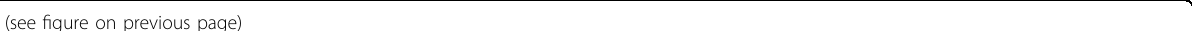
Fig. 6 Metabolic disease-related hIRS-1 G972R mutant displays altered phase transition dynamics. a DIC images of LLPS of FLAG-hIRS-1 and FLAG-hIRS-1 G972 mutants at a series of protein concentrations (5 or 10 μ M). The proteins were incubated with phase separation buffer at room temperature for 10 min. Scale bar, 20 µm . b Immunoblot analysis of the IRS-1 expression levels in C2C12 wildtype, C2C12-IRS-1 KO/GFP-hIRS-1, and C2C12-IRS-1 KO/GFP-hIRS-1 G972R cell lines. c Confocal images of GFP-tagged hIRS-1 or G972R mutant in C2C12-IRS-1 KO/GFP-hIRS-1 or C2C12-IRS-1 KO/GFP-hIRS-1 G972R cell lines. Scale bar, 10 µm. Quanti fi cation results of GFP-hIRS-1 or G972R puncta are shown as violin plots. * p < 0.05. d FLAG- tagged hIRS-1 or hIRS-1 G972R mutants were co-transfected with GFP-hIRS-1 into 293 T cells for immunoprecipitation analysis. Data in the bar graphs represent the mean ± SEM values of the ratios of densities for three independent experiments. *** p < 0.001. e FLAG-tagged mIRS-1 801 – 1000 or mIRS-1 801 – 1000 G965R mutant was co-transfected with GFP-mIRS-1-301-600 into 293 T cells for immunoprecipitation analysis. Data in the bar graphs represent the mean ± SEM values of the ratios of densities for three independent experiments. **** p < 0.0001. f Immunoblot analysis of total and phosphorylated AKT and ERK levels in C2C12 wildtype, C2C12-IRS-1 KO, C2C12-IRS-1 KO/GFP-hIRS-1, or C2C12-IRS-1 KO/GFP-hIRS-1 G972R cell lines treated with or without IGF-1 conditional medium for 2.5 min. Data in the bar graphs represent the means ± SEM values of the ratios of densities for three independent experiments. * p < 0.05, *** p < 0.001, **** p < 0.0001. ns: not signi fi cant. g GFP-tagged hIRS-1 wildtype and G972R mutant were immunoprecipitated in IGF-1-stimulated or control C2C12-IRS-1 KO/GFP-hIRS-1, or C2C12-IRS-1 KO/GFP-hIRS-1 G972R cell lines and then subjected to Western blot with p85 or Grb2 antibodies. Data in the bar graphs represent the mean ± SEM values of the ratios of densities for three independent experiments. * p < 0.05. *** p < 0.001. h Confocal images of endogenous p85 and GFP-hIRS-1 or G972R mutants in the indicated cell lines. Scale bar, 10 µm. Line scan showing the related intensity pro fi les of hIRS-1 with p85. The GFP-hIRS-1 or mutant puncta co-localized with p85 were quanti fi ed ( n = 33). Data in the bar graphs represent the means ± SEM. **** p <